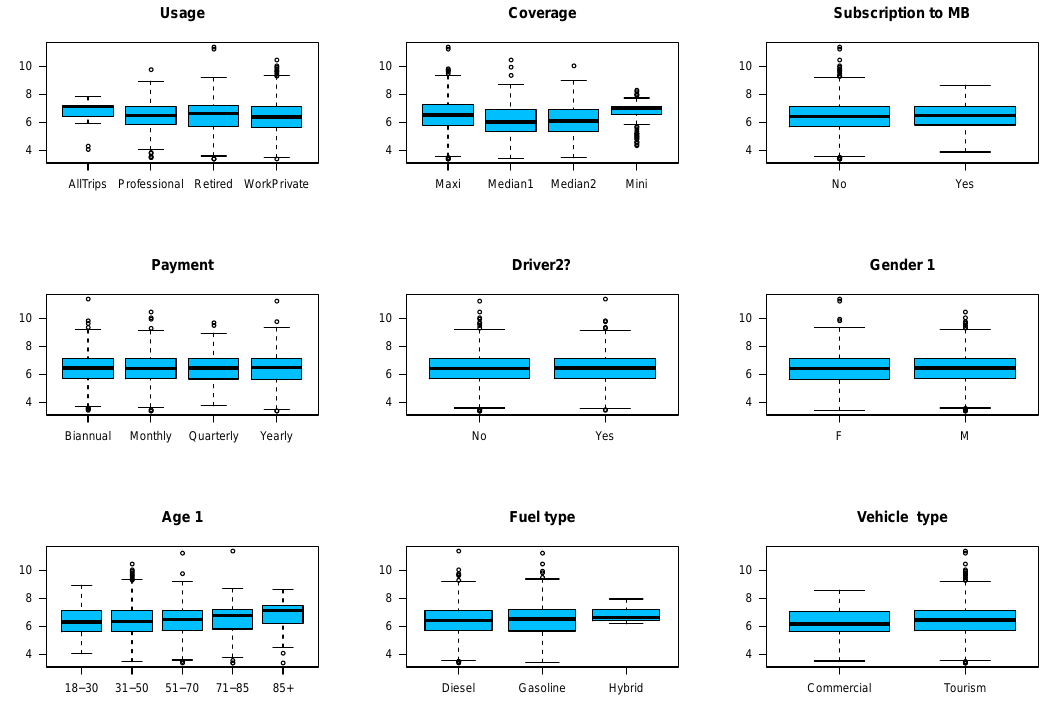
Figure 3. Distribution of log of claims amounts according to categorical variables.